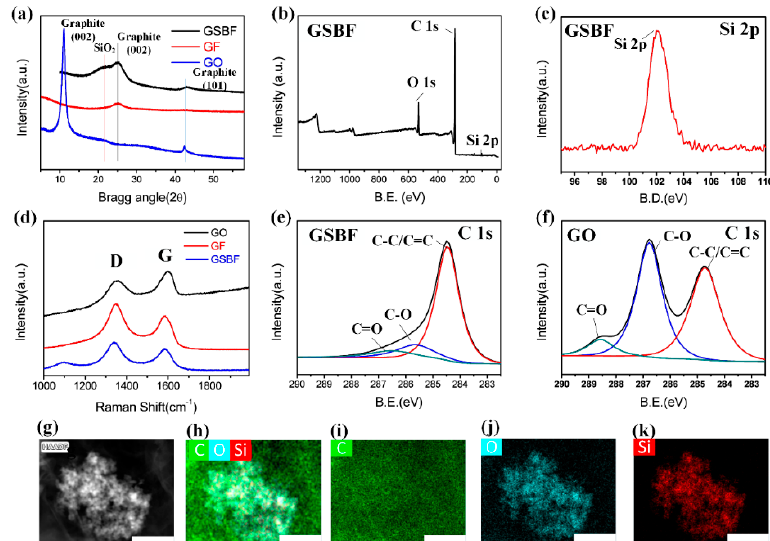
Figure 3. ( a ) The X-ray diffraction (XRD) spectra of three-dimensional graphene composite foam (GSBF), graphene foam (GF), and graphene oxide (GO). ( b ) X-ray photoelectron spectroscopy (XPS) spectrum of GSBF. ( c ) XPS spectrum of Si 2p. ( d ) Raman spectra of GSBF, GF and GO. ( e , f ) Curve